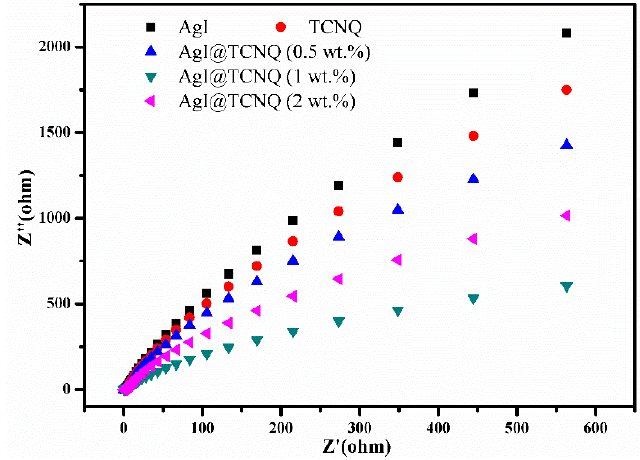
Figure 6. Electrochemical impedance spectroscopy for AgI and AgI@TCNQ samples.